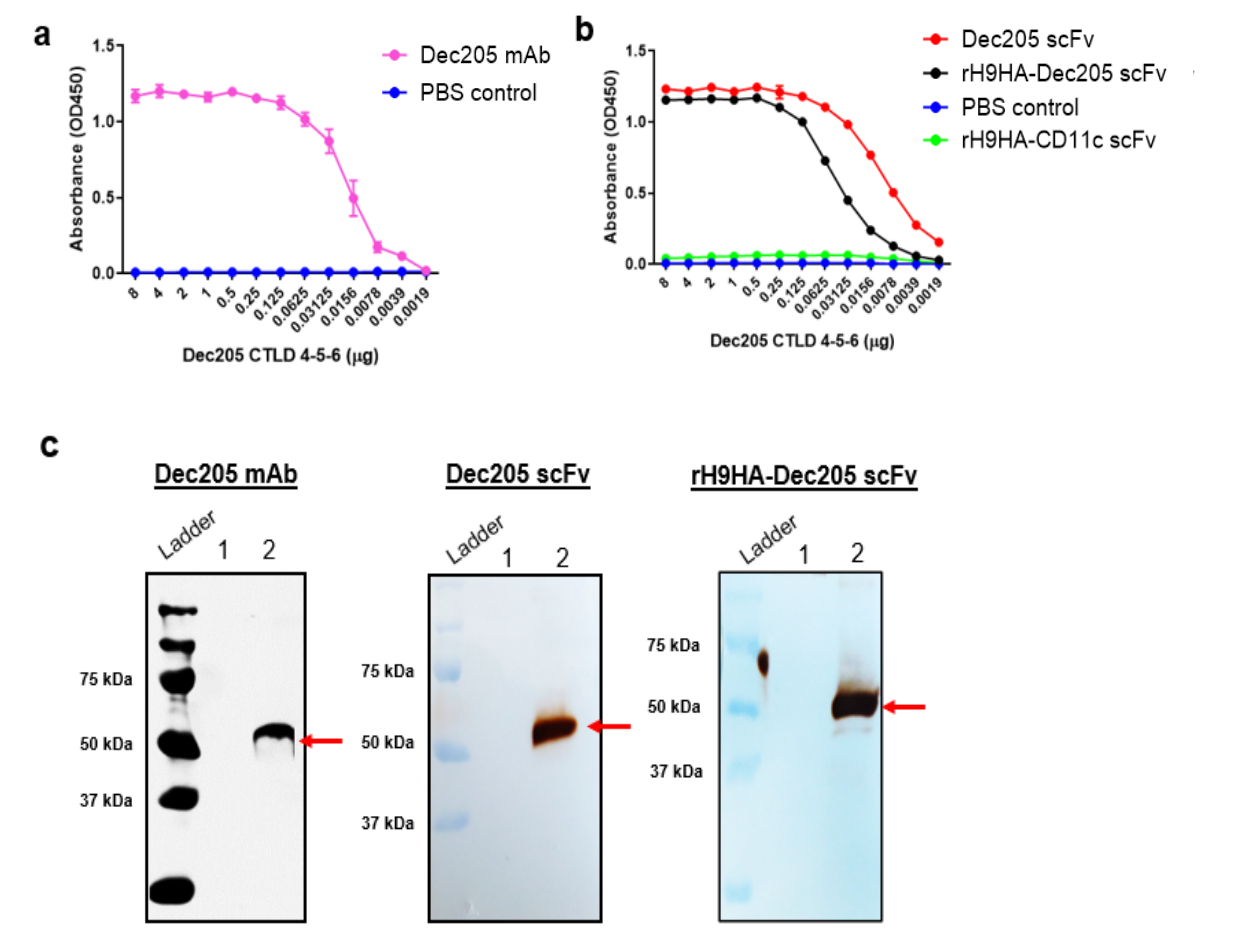
Figure 3. Characterisation of Dec205 mAb, Dec205 scFv and rH9HA-Dec205 scFv using ELISA and western blot assays ( a , b ) ELISA analysis for testing the ability of Dec205 mAb, Dec205 scFv and rH9HA-Dec205 scFv to bind to chicken Dec205 CTLD 4-5-6. About 8 μ g of purified chicken Dec205 CTLD 4-5-6 was coated onto each well of the ELISA plate, a two-fold serial dilution was carried out and the plate was incubated overnight for 4 °C. For detection, the plates were incubated 1 μ g/mL of Dec205 mAb or equimolar concentration of Dec205 scFv and rH9HA-Dec205 scFv. This was followed by incubation with goat anti-mouse HRP secondary antibody for Dec205 mAb (1:1000) and HRP-conjugated anti-V5 secondary antibody for Dec205 scFv and rH9HA-Dec205 scFv (1:1000). The colorimetric detection was carried out by adding TMB substrate and absorbance at 450 nm was recorded. No significant differences were observed in the binding between Dec205 scFv and rH9HA-Dec205 scFv. ( c ) Western blot analysis for testing the ability of Dec205 mAb, Dec205 scFv and rH9HA-Dec205 scFv to detect chicken Dec205 CTLD 4-5-6. In all cases, lane 1 represents untransfected cell supernatant control whereas lane 2 represents chicken Dec205 CTLD 4-5-6 (red arrow). The chicken Dec205 CTLD 4-5-6 was run on 10% SDS-PAGE, blotted onto nitrocellulose membrane, and immunodetected using the same primary and secondary antibodies as that of the ELISA assay.